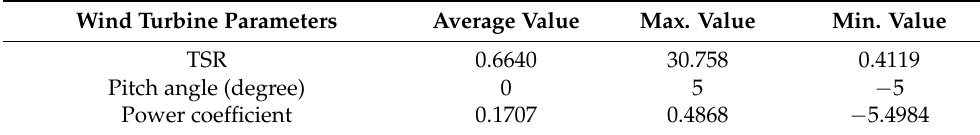
Table 1. Statistical properties of wind turbine data [71]. Wind Turbine